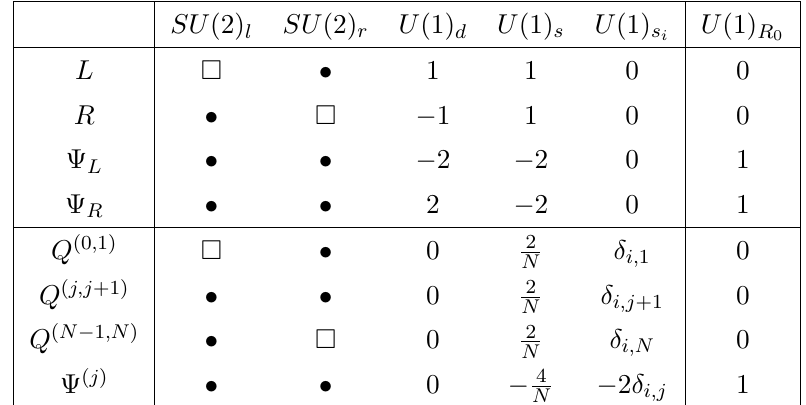
Table 8 . Transformation rules of the matter fields of theory T A and theory T ( N )